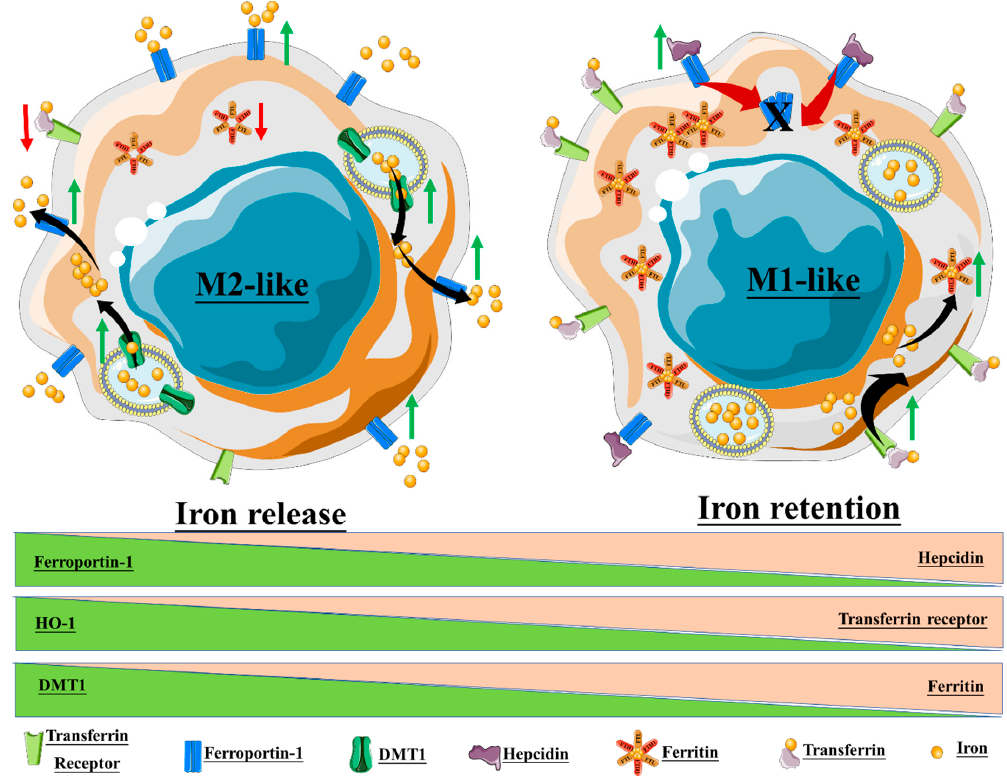
Figure 6. Macrophage polarization and iron homeostasis. The M2-like phenotype exhibits high expression of ferroportin-1, the divalent metal transporter-1 (DMT1), and heme oxygenase-1 (HO-1), thus promoting a state of iron release. On the contrary, the M1-like phenotype promotes intracellular iron retention through the upregulation of ferritin, hepcidin, and the transferrin